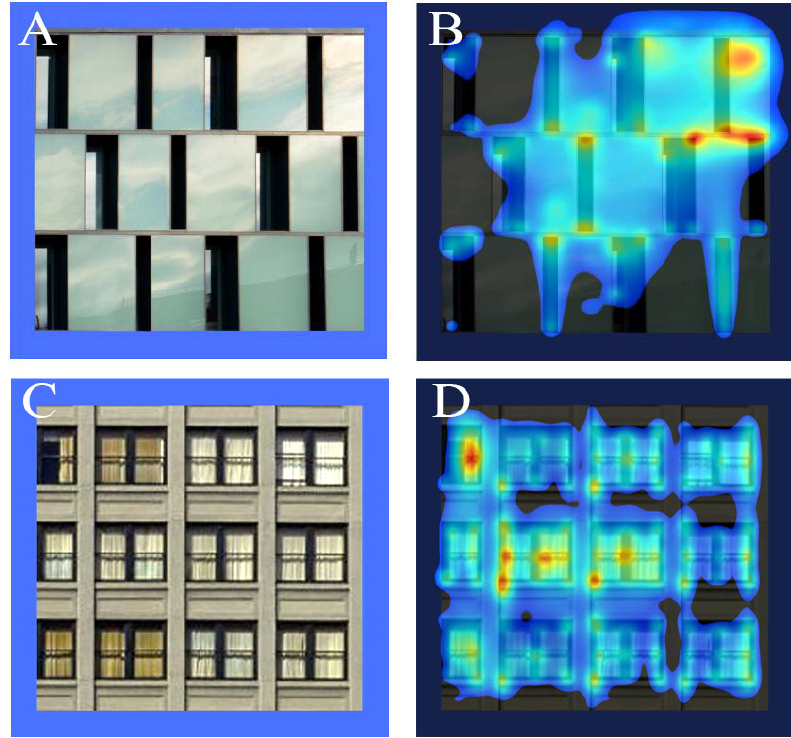
Figure 5. Partial, equal size view of the newer-style buildings from Figure 4, above. ( A ) Magnified façade of the Omega Palace, with ( B ) eye-tracking simulation heatmap. ( C ) Magnified façade of the background San Diego building in Figure 4C, with ( D ) eye-tracking simulation heatmap.